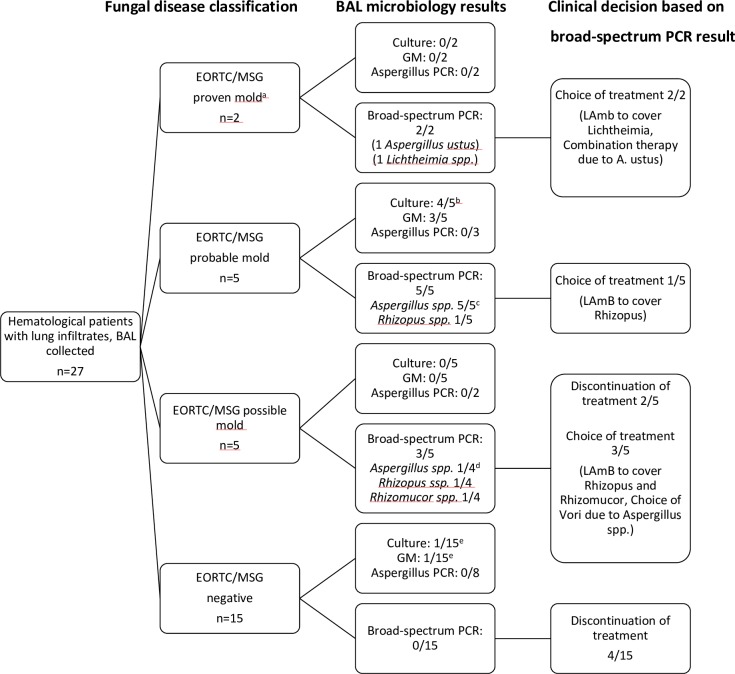
Microbiology findings in BAL where PCR/ESI-MS was performed.BAL: bronchoalveolar lavage; GM: galactomannan. aMicroscopic findings of hyphae in lung biopsy in both patients. bAspergillus fumigatus: 3, Aspergillus flavus: 1. cAspergillus fumigatus: 2, Aspergillus fumigatus+Rhizopus spp: 1, Aspergillus flavus: 2. dAspergillus fumigatus. eGrowth of Aspergillus fumigatus in one patient and GM positive in another patient, but the pulmonary infiltrates did not meet clinical criteria in either patient. Both were treated as invasive pulmonary aspergillosis.